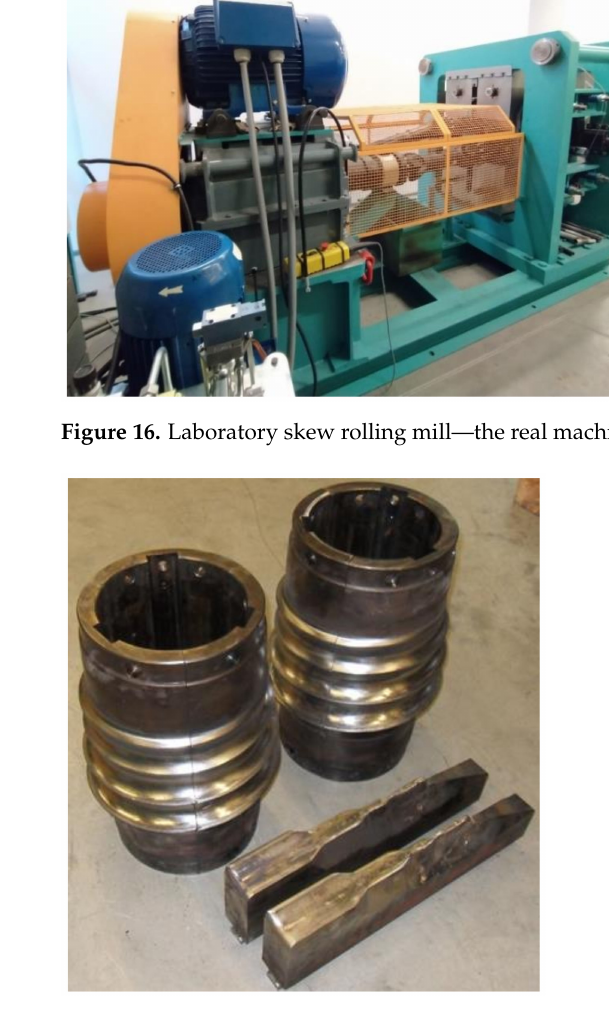
Figure 17. Second type tools for real research.